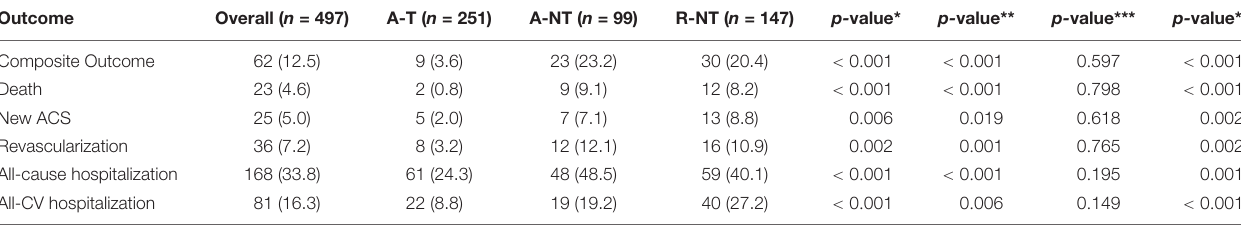
TABLE 3 | Outcomes of patients included in the cardiac rehabilitation program and in the three groups.